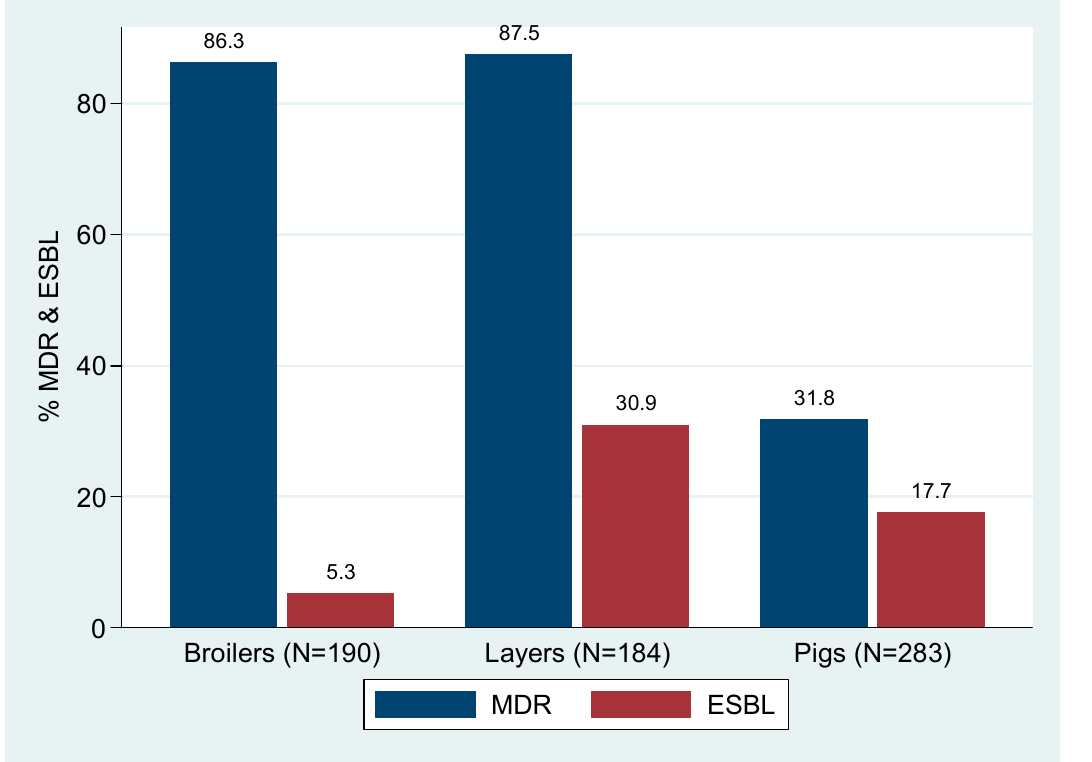
Figure 1. Percentages of MDR and ESBL E. coli from broilers, layers, and pigs.